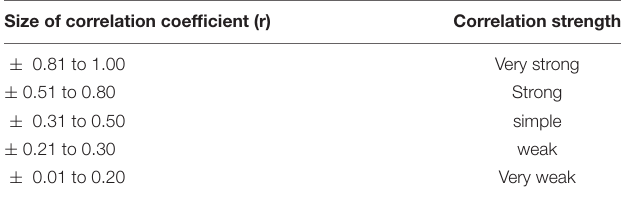
TABLE 3 | Relationship strength according to the value of the correlation coefficient. Size of correlation coefficient (r) Correlation